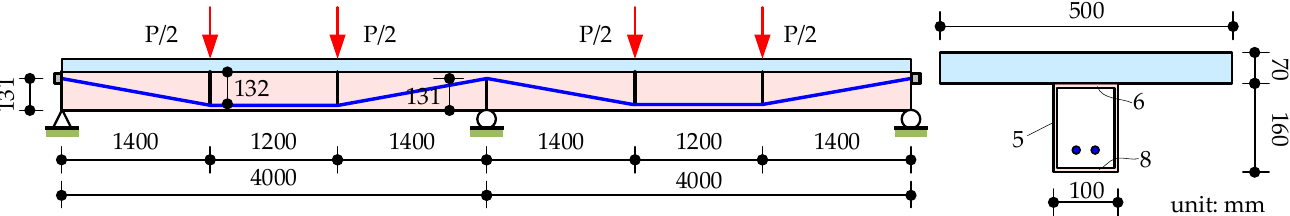
Figure 14. Analysis results of specimens B3 and B4.